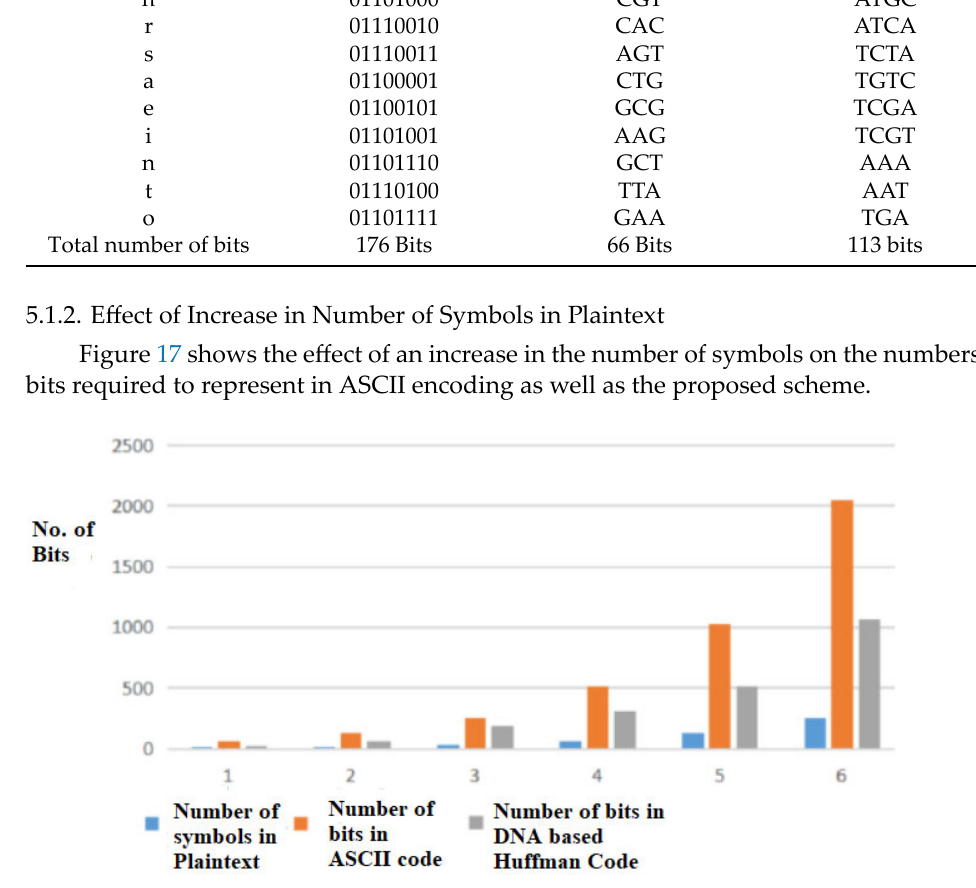
Figure 17. Comparison of number of bits needed in ASCII code and DNA‑based Huffman code as Number of Symbols in Plaintext is doubled.